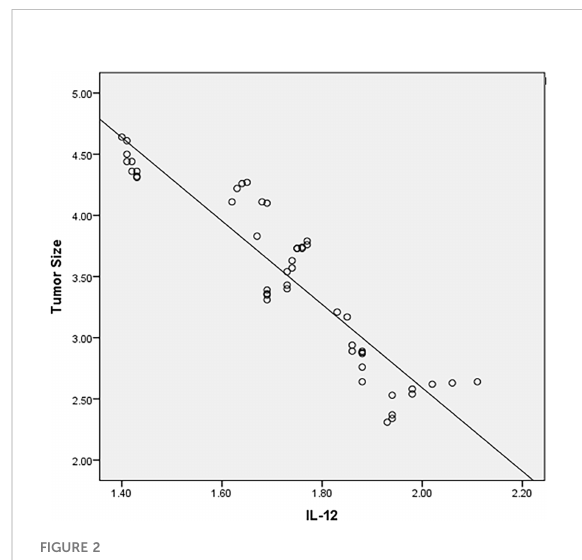
FIGURE 2 The correlation between the variation and ef fi cacy before and after the